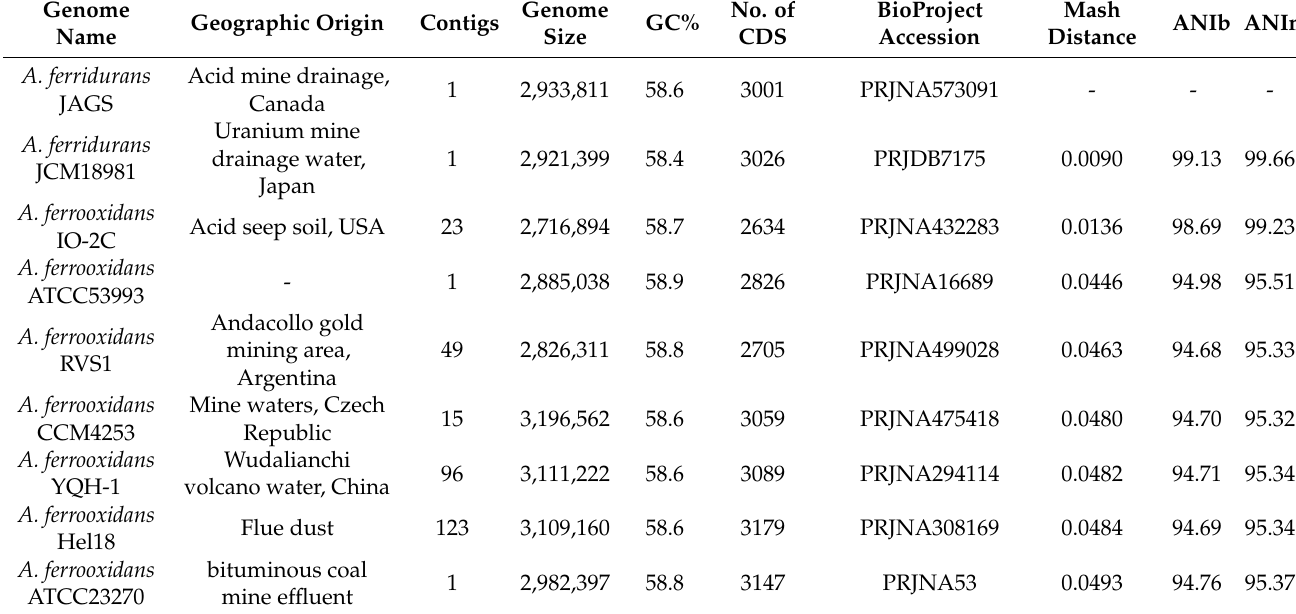
Table 1. General features and genomic comparison (pairwise mutation (Mash) distance, average nucleotide identity (ANI)) between A. ferridurans JAGS and selected representatives.